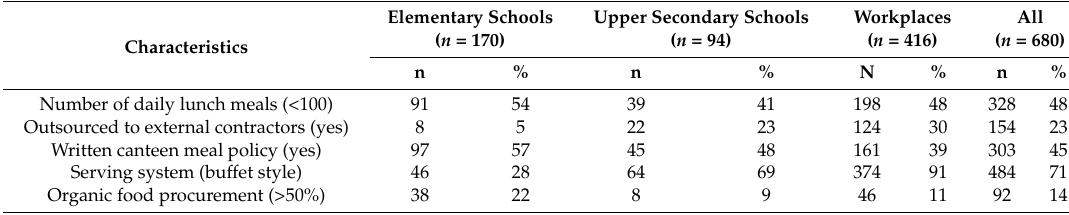
Table 2. Characteristics of the participating canteens.